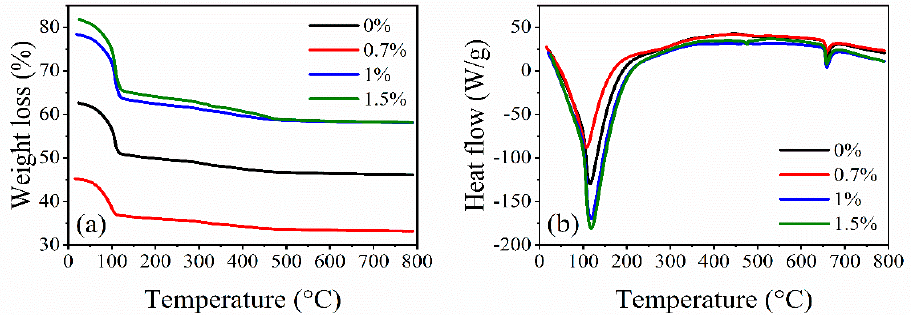
Figure 7. TGA ( a ) and DSC ( b ) curves representing weight loss and heat flow during the heating of the Thermacoat™ with up to 1.5% addition of polypropylene fibers.